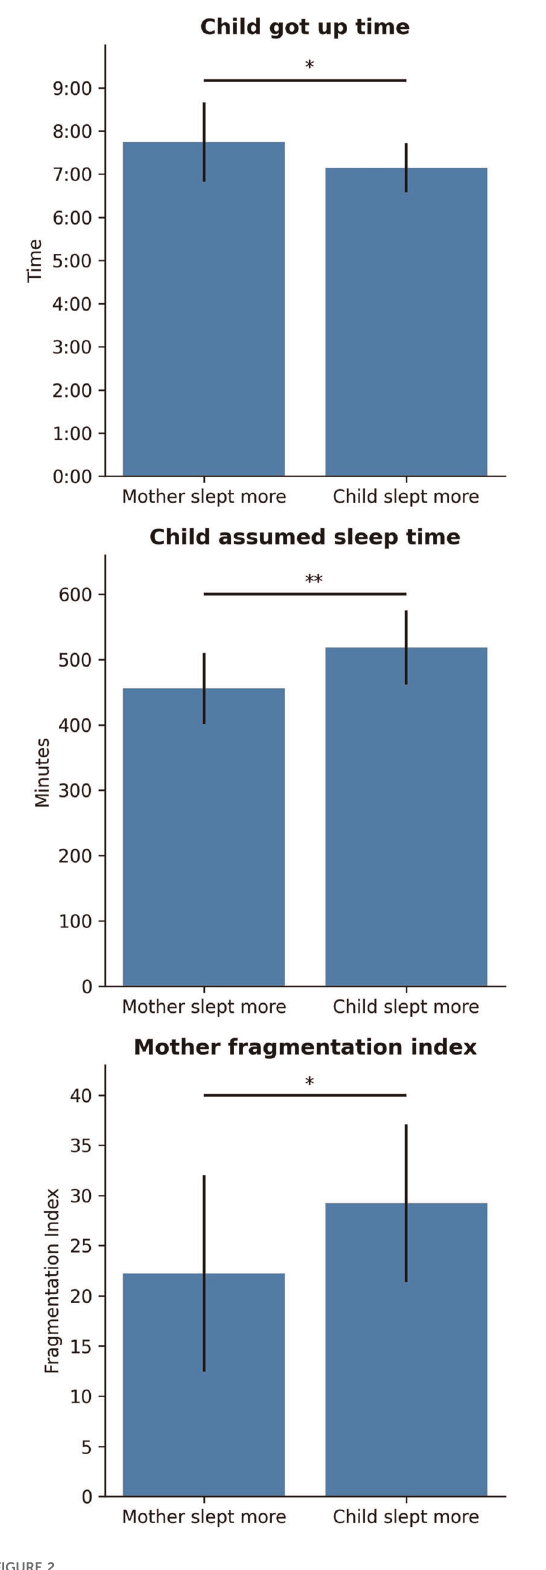
FIGURE 2 Comparison of sleep variables by group (mother slept more or child slept more). (cid:2) p , : 05, (cid:2)(cid:2) p , :